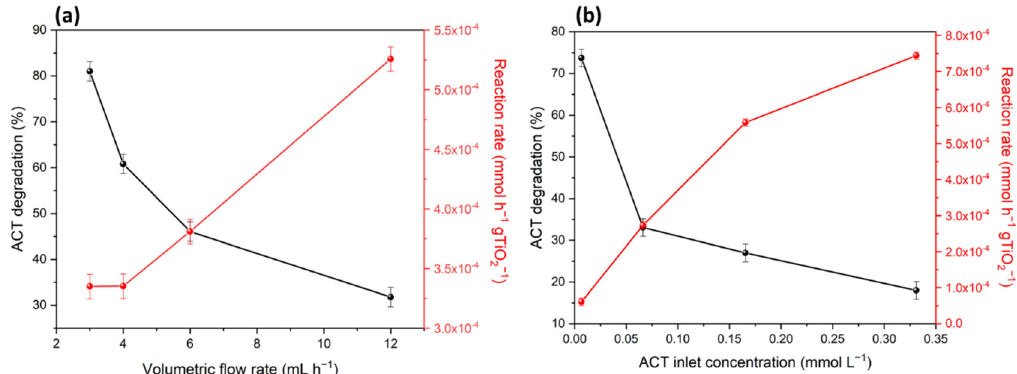
Figure 7. ( a ) Photocatalytic activity of the 0.25%Pt-TiO 2 /SiO 2 material for different volumetric flow rates. Error bars are based on triplicates of the optimum point. ( b ) Photocatalytic activity of the 0.25%Pt-TiO 2 /SiO 2 material for different ACT inlet concentrations. Error bars are based on triplicates of the optimum point).